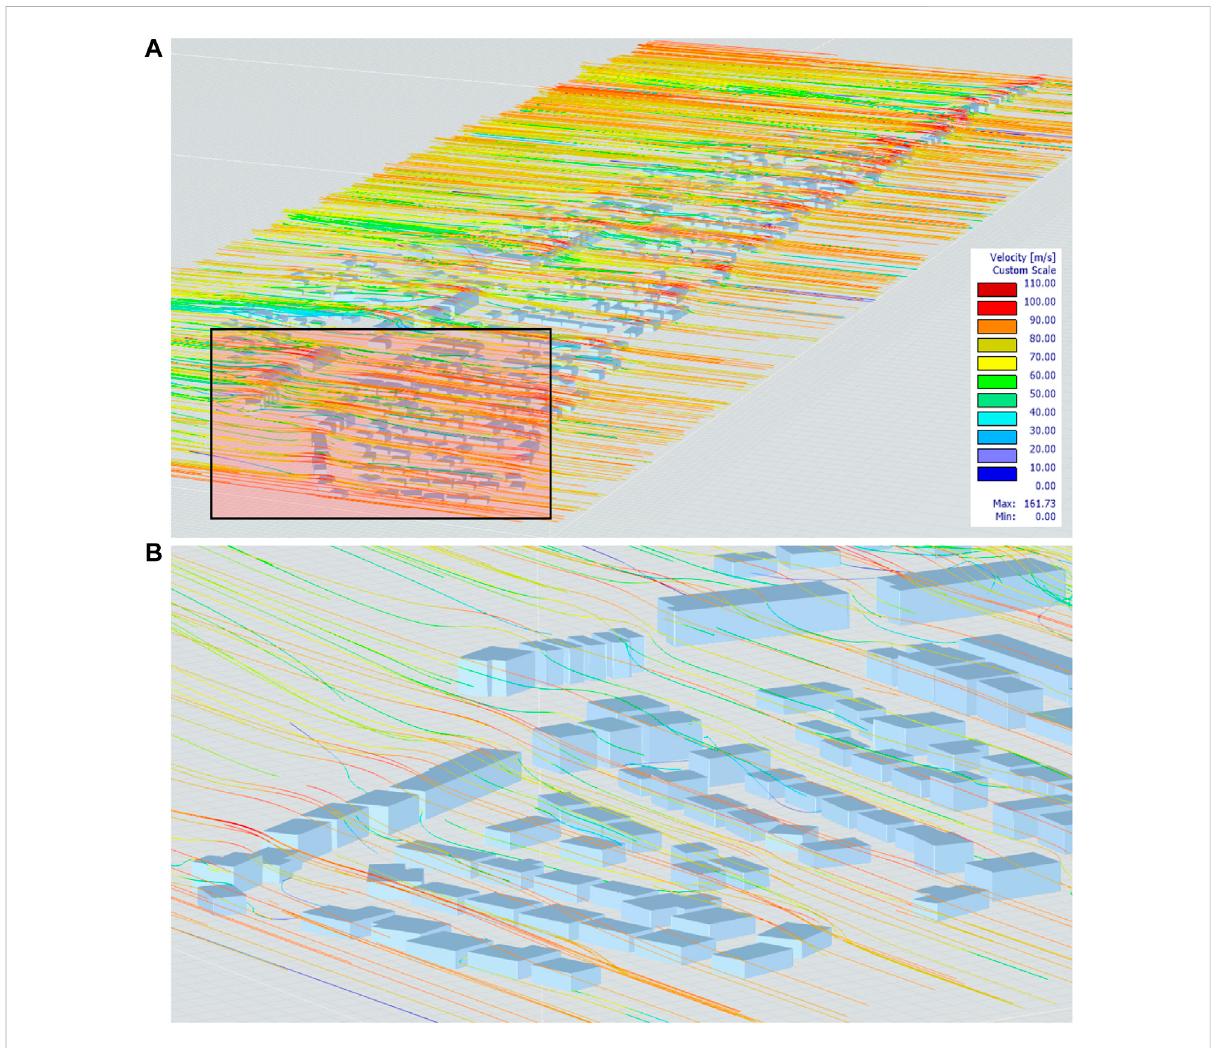
FIGURE 13 Wind fl ow analysis results (A) Wind fl ow lines across the community color-coded based on the variation of their wind speed; (B) Close-up view on the variation in wind fl ow and wind speed.